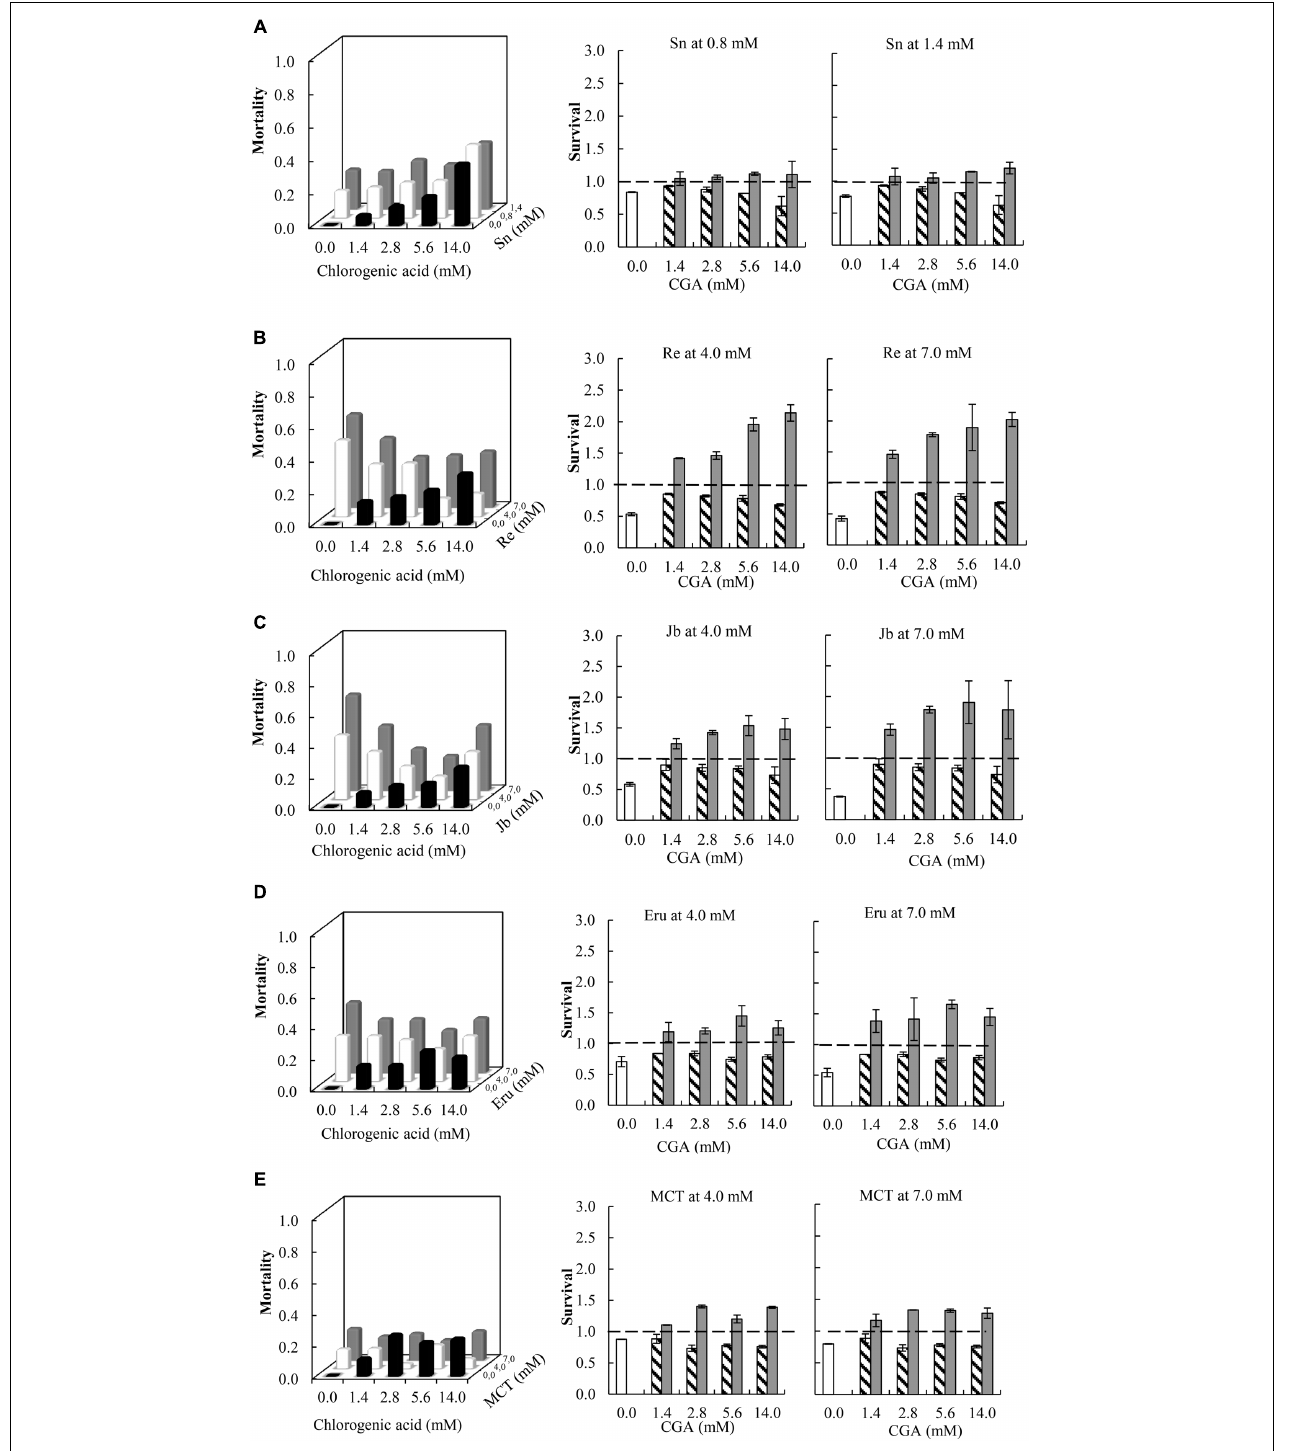
FIGURE 3 | Left: Fraction mortality (1- fraction survival) of 2nd instar thrips larvae ( Frankliniella occidentalis ) caused by the single metabolites and the combination of CGA with senecionine (A) , retrorsine (B) , jacobine (C) , erucifoline (D) , and monocrotaline (E) . Right: Fraction survival (mean ± 95% confidence intervals) of thrips caused by PA alone (white bars), CGA alone at four concentrations (hatched bars), and the interaction effect S X ∗ Y (Equation 4) between PAs and CGA (gray bars). In the left figures, the fraction mortality was plotted to increase the readability of the figure. In the right figures, dashed line indicates a thrips survival fraction of one. Deviation of the interaction effect S X ∗ Y from the dashed line (survival = 1) indicates synergistic ( < 1) or antagonistic effect ( > 1). Two-way ANOVAs were used to analyze whether the overall interaction effect S X ∗ Y deviated from one ( Table 1 ). Sn, senecionine; Re, retrorsine; Jb, jacobine; Eru, erucifoline; MCT, monocrotaline.